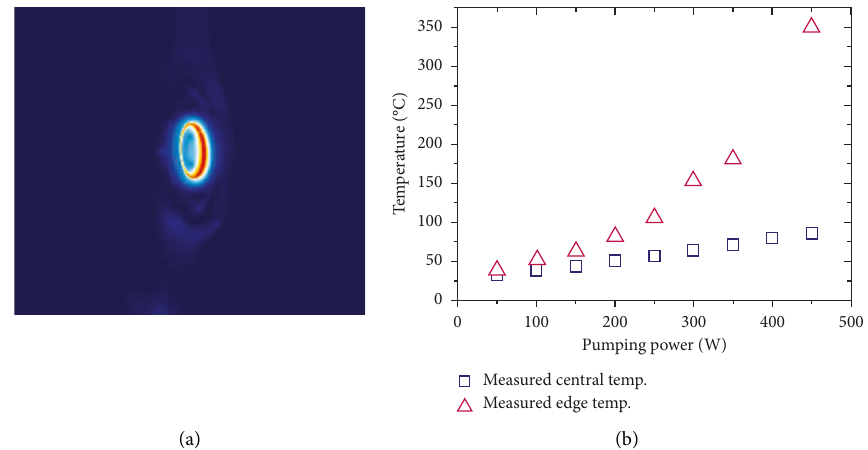
Figure 6: (a) The thermal image of the thin disk crystal taken by the infrared thermal imager. (b) The measured temperature from the edge and central of the thin disk crystal.